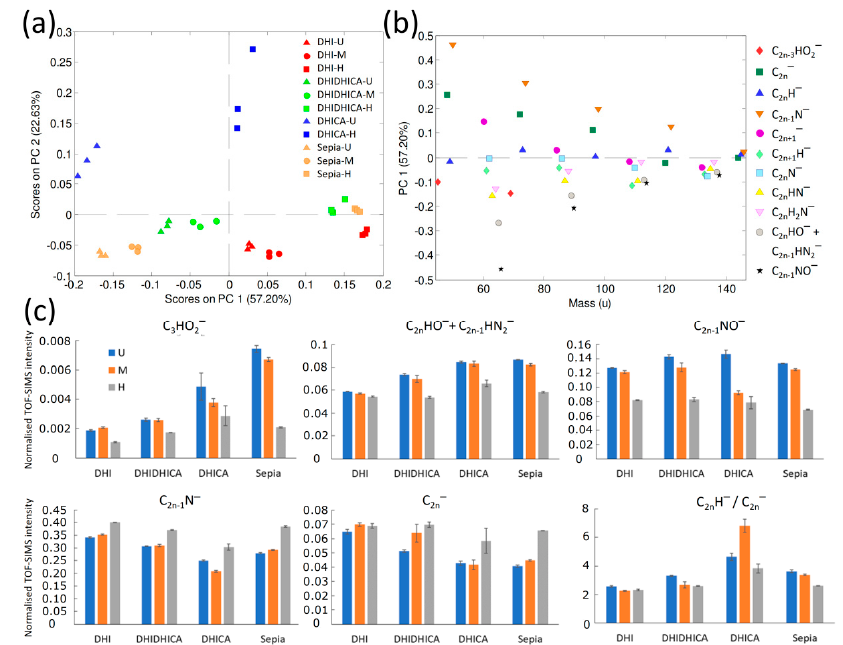
Figure 4. ToF-SIMS signal intensity analysis of negative ions in spectra derived from a selection of eumelanin samples. ( a ) Principal component analysis (PCA) score plot of spectra from DHI (red), DHI + DHICA (1:1) (green), DHICA (blue) and Sepia (orange) eumelanin; untreated samples (triangles), and samples after mild (circles) and harsh (squares) maturation, respectively. ( b ) PC1 loadings for peaks assigned to the ion categories indicated in the right-hand list (see also Table 2 for specific ion assignments and Supplementary Materials Figure S2 for PC2 loadings). ( c ) Added peak intensities of ions of some selected categories. The diagrams show mean values with error bars corresponding to ±1 standard deviation (N = 3). Abbreviations: U, untreated; M, mild treatment (100 °C/100 bar for 24 h); H, harsh treatment (250 °C/200 bar for 72 h). The spectra acquired from the DHICA eumelanin do not follow the same pattern as the other three pigment types, since they display higher PC2 scores and no co-localization with the other melanin samples after harsh maturation. This indicates different molecular characteristics of the DHICA melanin compared to the other samples.